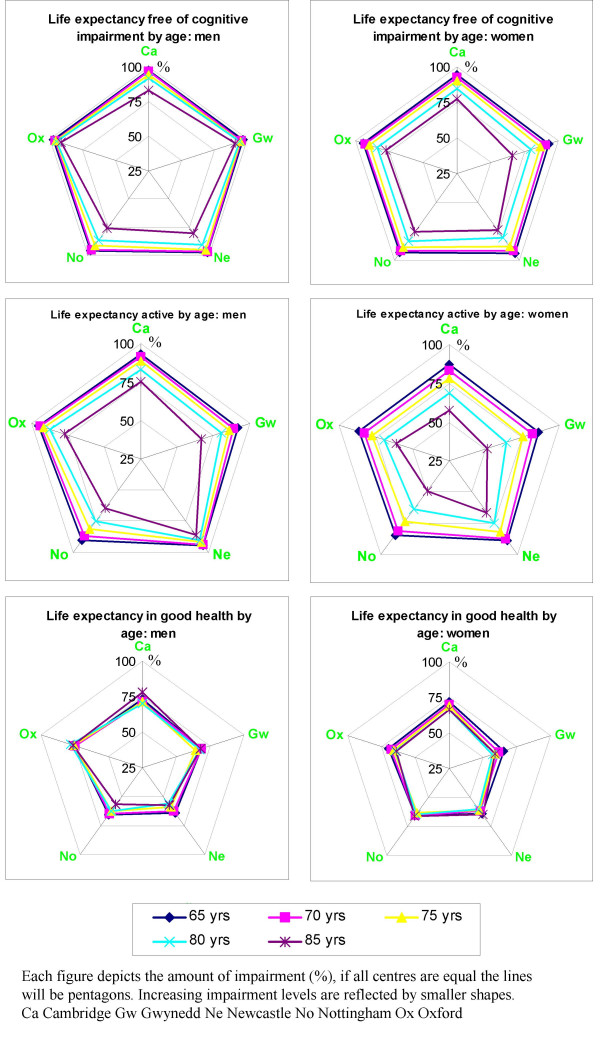
Proportion of remaining life spent active (free of functional impairment), in good self-perceived health and free of cognitive impairment by age and centre for men and women.